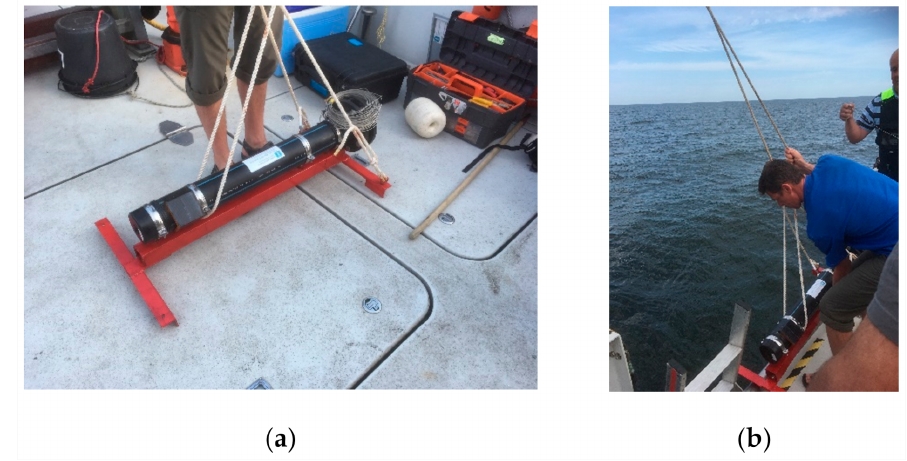
Figure 6. Pressure sensor-based buoy ( a ) and its deployment in the Gulf of Riga on 20 June 2019 ( b